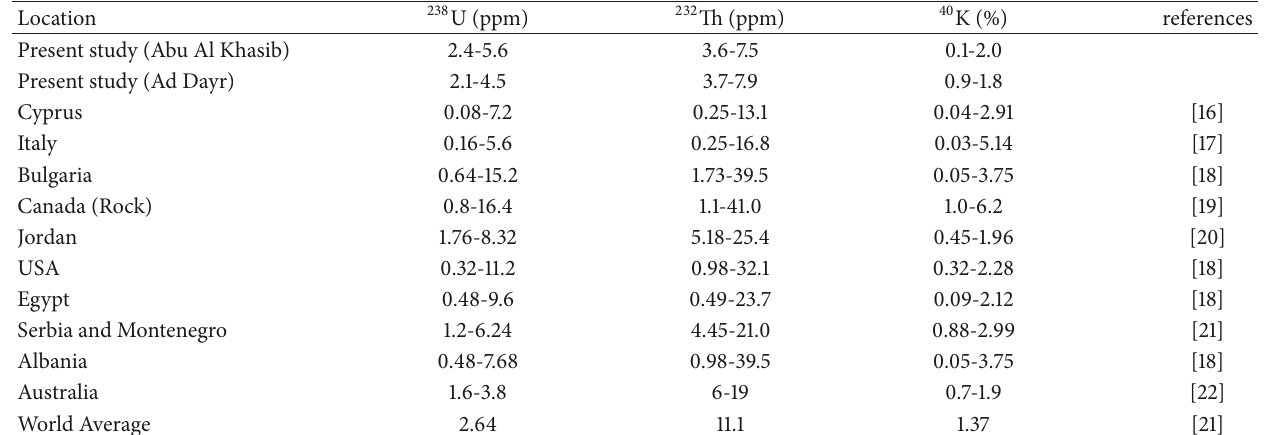
Table 6: A comparison of the mass concentrations of 238 U, 232 Th, and 40 K in clay soil samples evaluated in the present study with other locations around the